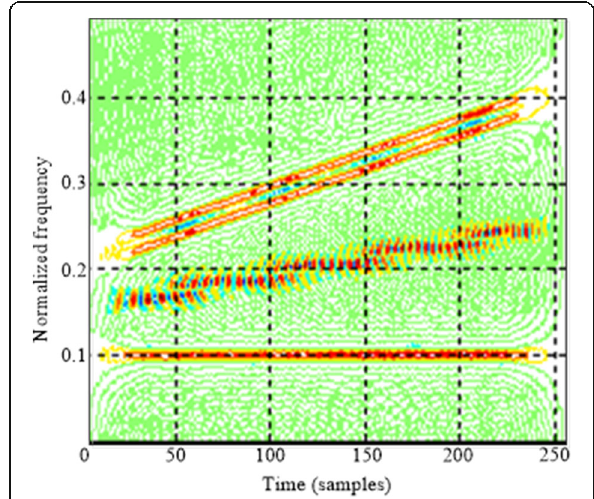
Fig. 3 WVD time-frequency transform of signals